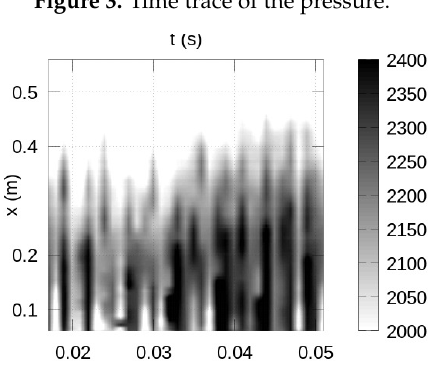
Figure 4. Map of centerline temperature in space-time. The grey bar denotes degrees Kelvin.